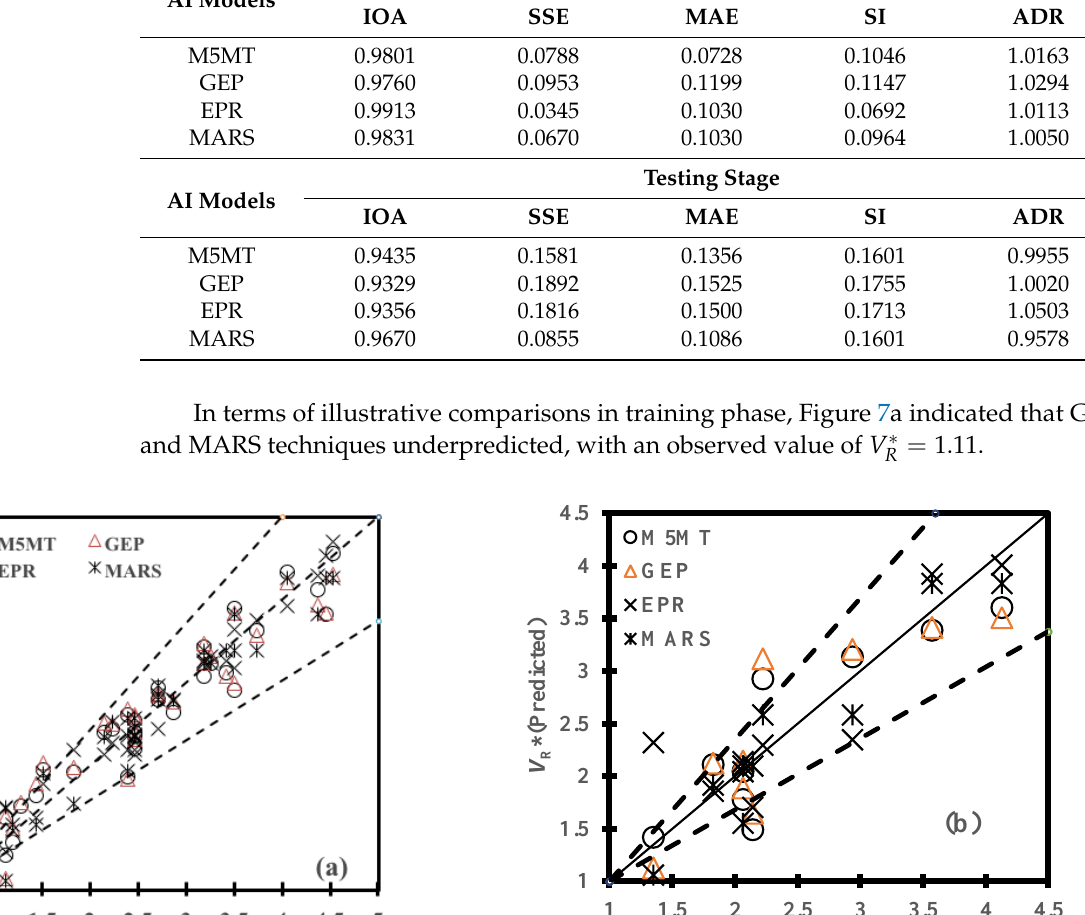
Table 4. Statistical performances of the AI models in the estimation of V ∗